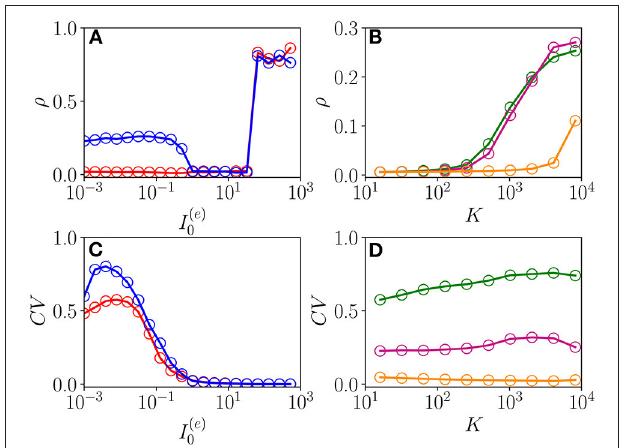
FIGURE 10 | Frequencies and amplitudes of O F oscillations. The two FIGURE 8 | From fluctuation driven to abnormally synchronized oscillations. fundamental frequencies ν 1 and ν 2 vs. I ( e ) 0 (A) and K (C) and the average firing Coherence indicator ρ (Equation 4) for the whole network of excitatory and rates vs. I ( e ) 0 (B) and K (D) for the excitatory (red) and inhibitory (blue) inhibitory neurons vs. the excitatory DC current I ( e ) 0 (A) and the median populations. In the inset in (C) , the effective mean input currents I ( e ) eff ( I ( i ) eff ) of the in-degree K (C) . Coefficient of variation CV for the whole network vs. I ( e ) 0 (B) excitatory (inhibitory) population are shown vs. K . The dashed line in (A,C) and K (D) . In (A,C) , the symbols refer to different values of the median K 1 / 4 ) for the frequencies of the I ( e ) 0 1 / 2 ( corresponds to a power law-scaling ∝ ∝ in-degree:namely, K 100 (red circles) and K =4,000 (blue circles). In (B,D) , COs. The solid red (blue) line in (B,D) denotes the asymptotic MF result R ( e ) = 0.01 (green the symbols refer to different excitatory DC currents: namely, I ( e ) 0 = ( R ( i ) ). Network (MF) simulations are denoted as stars (circles). The MF data 0.1 (purple circles), and I ( e ) 0 1.0 (orange circles). Parameters as circles), I ( e ) 0 = = refer to the stable focus, in particular, in (A,C) , these are the two relaxation in Figure 1 , other parameters 1 ( ii ) 0 frequencies ν R 1 and ν R 2 . Parameters as in Figure 1 , other parameters: (A,B) K 1,000, 1 ( ee ) 0 1.58, 1 ( ii ) 0 0.3; (C,D) I ( e ) 0 0.001, 1 ( ee ) 0 1.3, 1 ( ii ) 0 0.3; = = = = = = for the network simulations, we employed N ( e ) 80,000 and N ( i ) = =